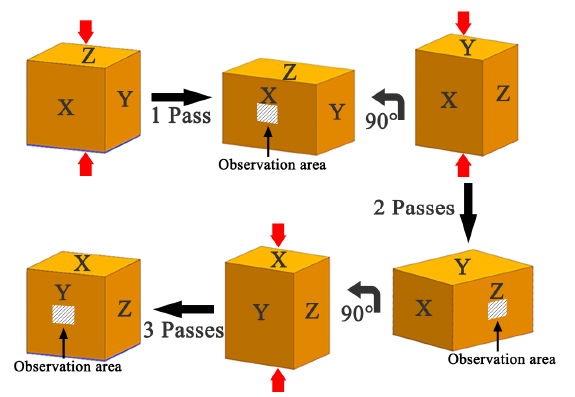
Figure 1. Experimental process and observation location.